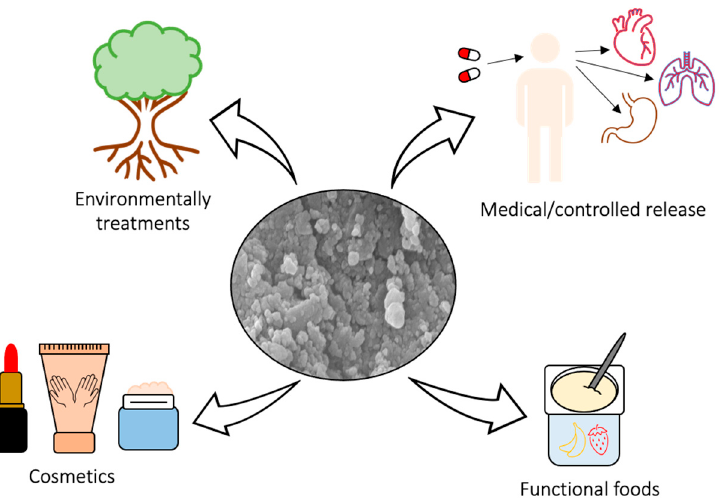
Figure 11. Schematic representation of different fields in which SNPs can be used.